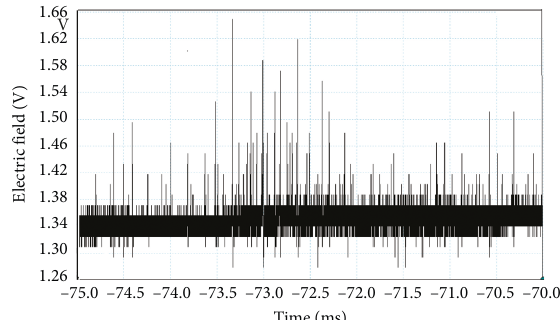
Figure 9: An expansion of the first stage of three-stage typical cloud flash of Figure 8.